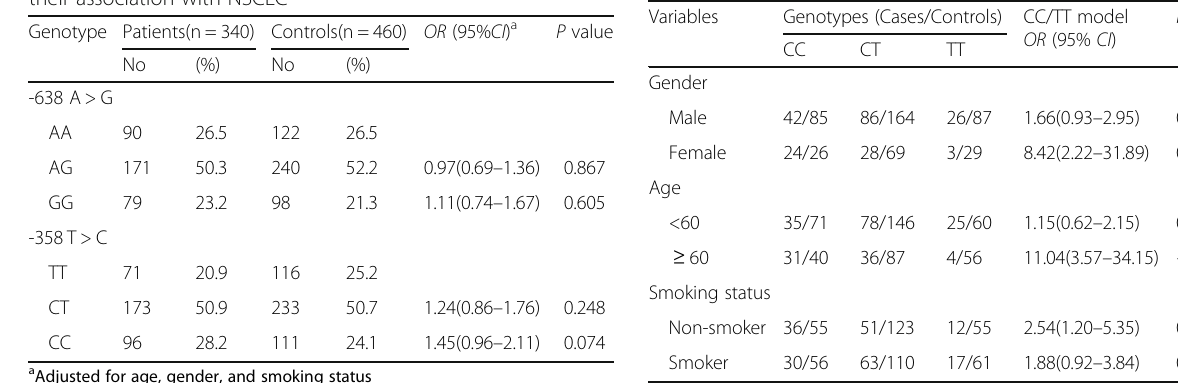
Table 5 Association of TNFSF15 -358 T > C polymorphism with SCLC risk stratified by selected